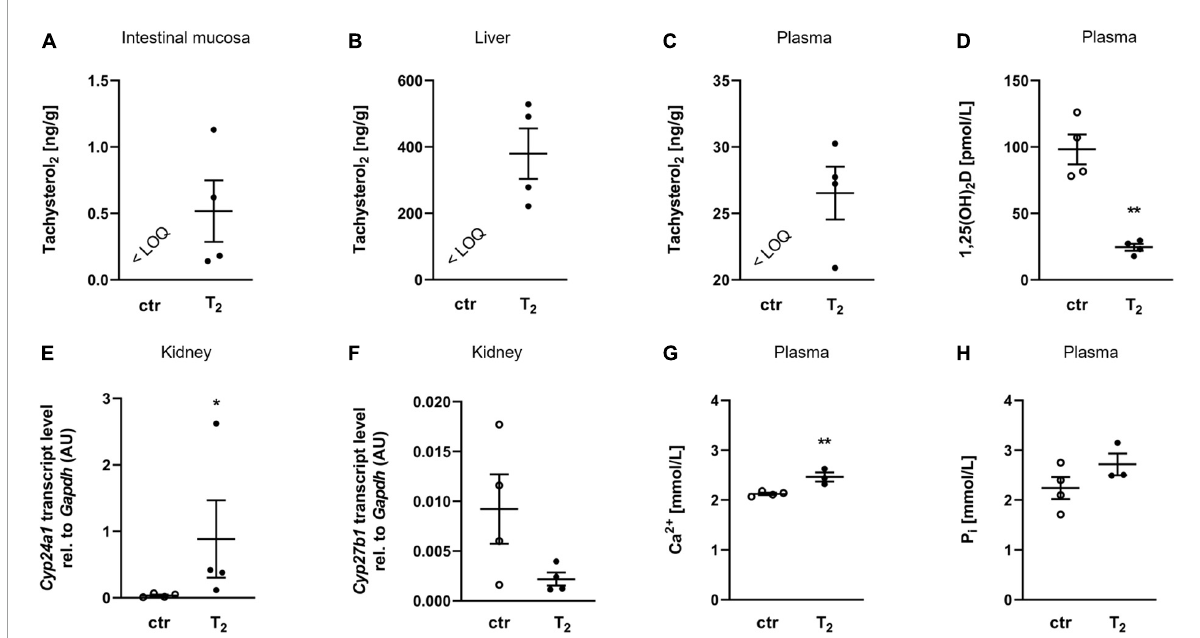
FIGURE1 Oral tachysterol 2 enters the body and affects vitamin D metabolism. Scatter dot plots and arithmetic means ± SEM of concentrations of tachysterol 2 (T 2 ) in the intestinal mucosa (A) , liver (B) and plasma (C) , plasma concentration of 1,25(OH) 2 D (D) , relative (rel.) renal Cyp24a1 mRNA abundance (normalized to Gapdh ) (E) , rel. renal Cyp27b1 mRNA abundance (normalized to Gapdh ) (F) , plasma concentration of ionized calcium (Ca 2 + ) (G) , and plasma concentration of inorganic phosphate (P i ) (H) of mice fed diets with 0 (ctr) or 4 mg/kg T 2 for 2 weeks ( A–F : n = 4). * p < 0.05 and ** p < 0.01 indicate significant differences from the control. The limit of quantification (LOQ) for T 2 was 0.4 nM in plasma and 0.4 ng/g in tissue samples. 1,25(OH) 2 D, active vitamin D, calcitriol; AU, arbitrary units; ctr, control [ D,F : unpaired Student’s t -test with Welch’s correction; (E) Mann-Whitney U -test; (G,H) unpaired Student’s t- test ( n =